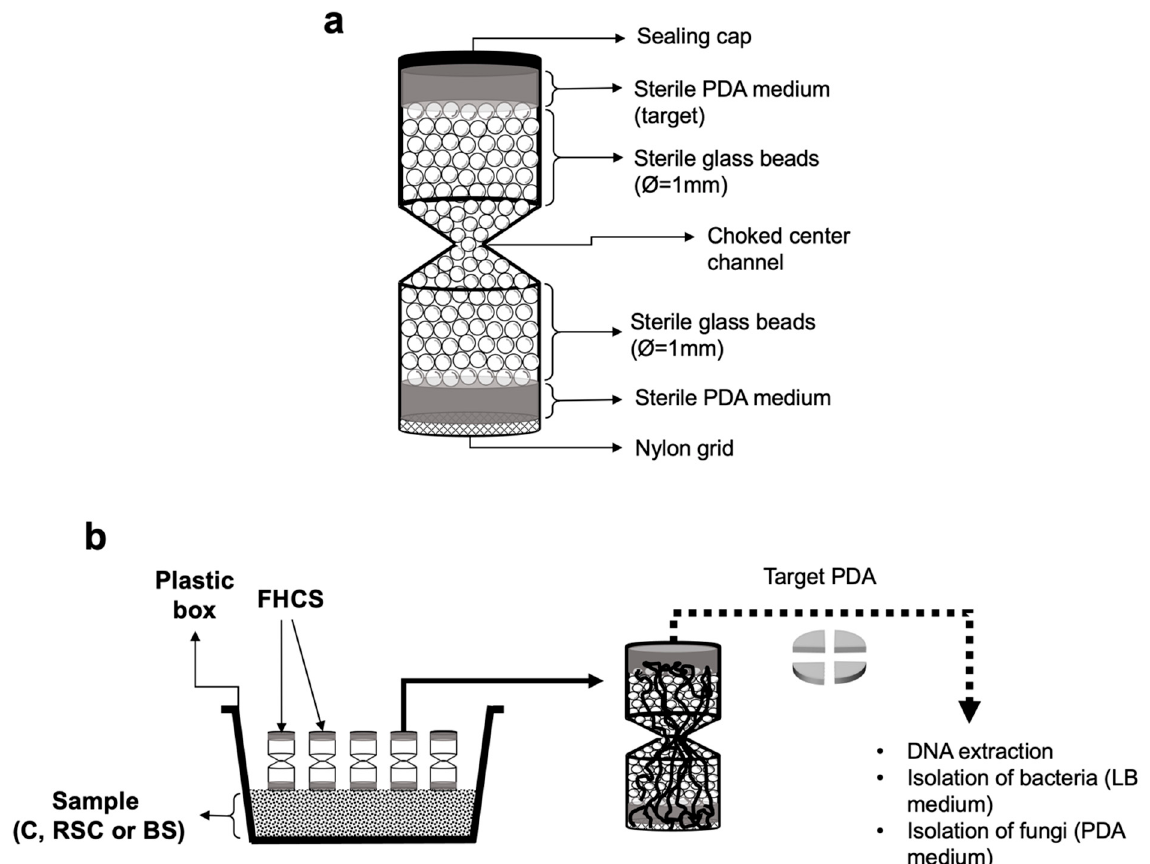
Figure 1. ( a ). Schematic of fungal highway column systems (FCHS) used to the isolation of fungal and their hyphae- associated bacterial strains from compost (C), rhizosphere soil with compost application (RSC) and bulk soil (BS) samples. PDA: potato dextrose agar; LB: Luria Bertani agar. ( b ). Schematic of experimental workflow for isolation and identification of microorganisms from different samples using FCHS.